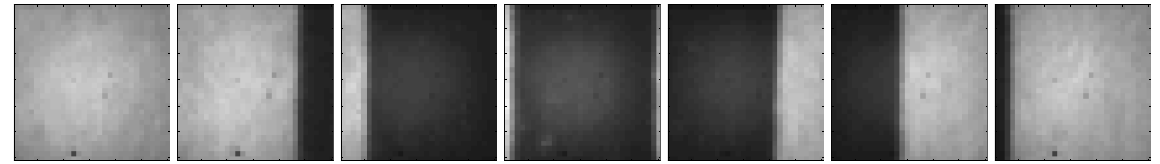
Figure 6. Some images captured by the ADNS-3088 optical mouse sensor when moving over a black line of 1.2 mm width.